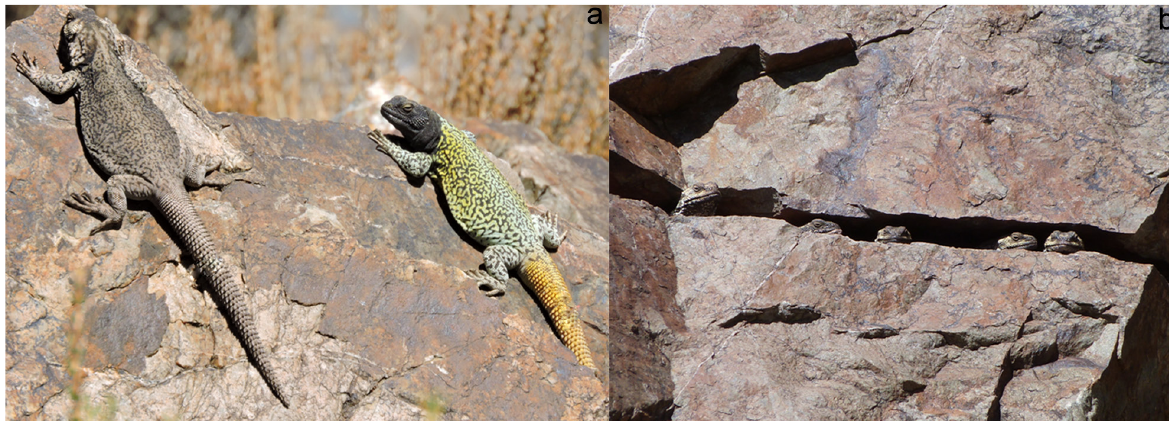
Figure 1. a) Female (lizard at the left of the figure) and male of Phymaturus palluma sharing a basking site. b) Male, females and juveniles sharing a retreat